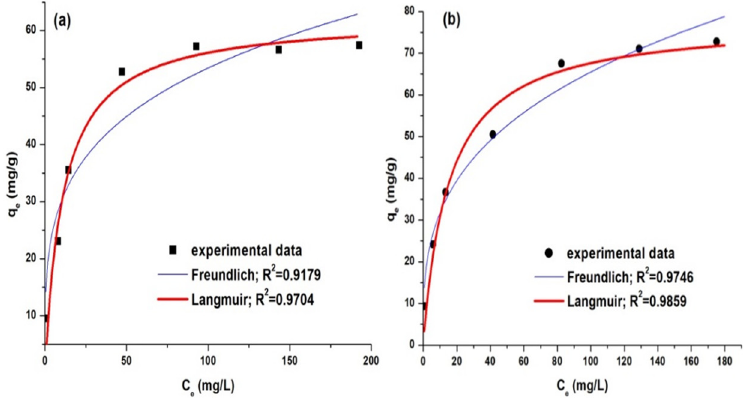
Figure 14. Correlation of experimental data with adsorption isotherms for dye adsorption: AY 42 ( a ) and AR 213 ( b ).